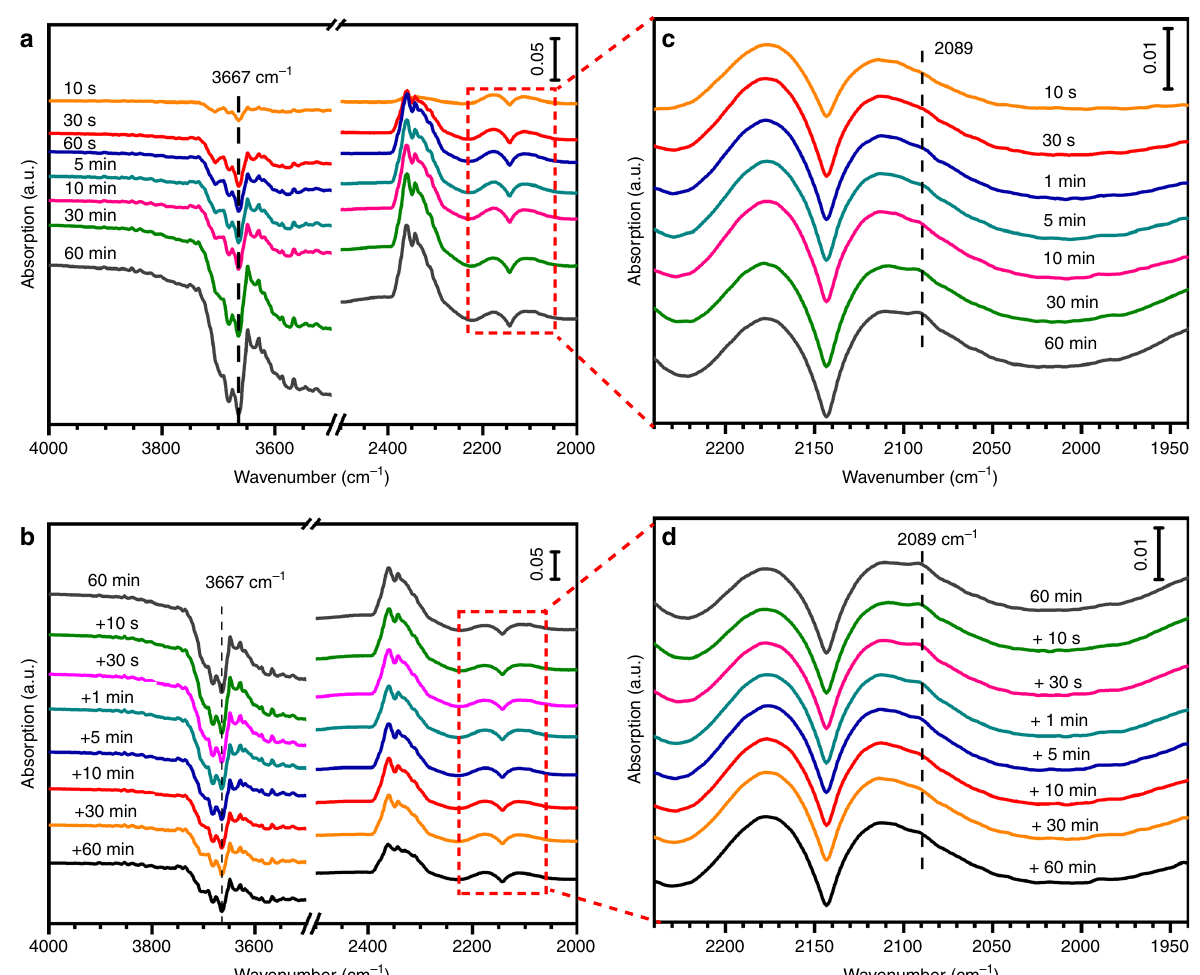
Fig. 4 In-situ DRIFT spectra of Au 1 /CeO 2 as a function of reaction time at 200 °C. a : CO oxidation without the presence of H 2 O. Reaction condition: 1 vol% CO + 2 vol% O 2 balanced He, fl owrate: 50 mL min − 1 ; and b : introducing 2 vol% H 2 O after a . Here c and d are enlargement of the corresponding spectra in box in a and b ,